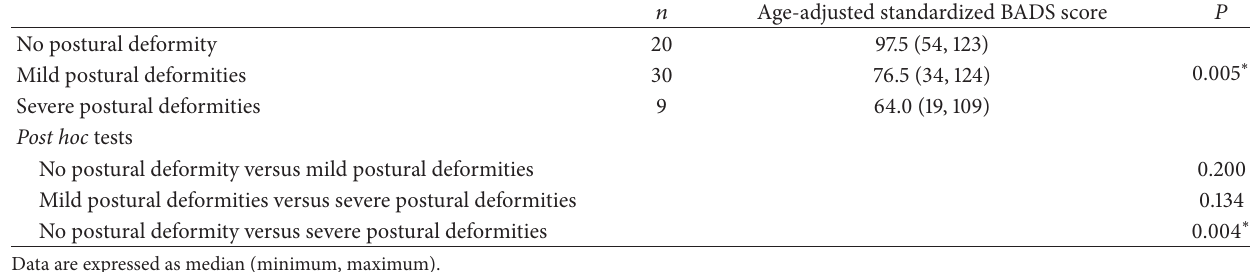
Table 2: Relationship between age-adjusted standardized BADS score and severity of postural deformities in patients with PD.